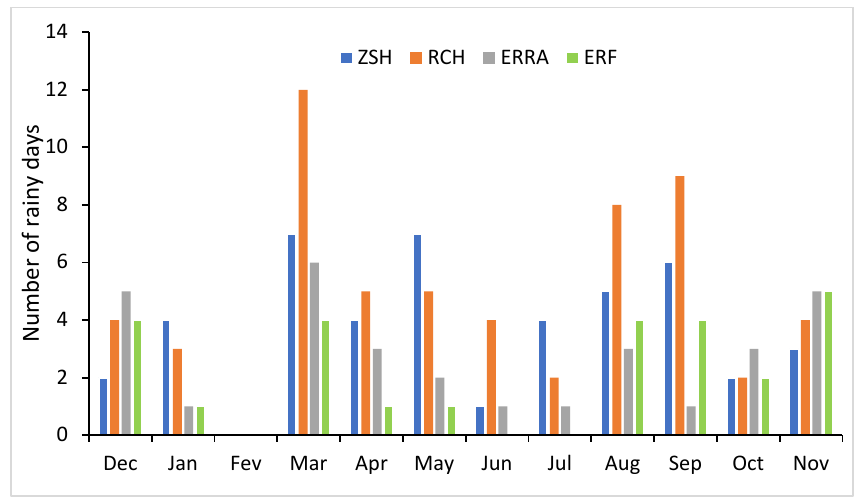
Figure 7. Number of rainy days at the four sampling stations (period December 2019–November 2020).